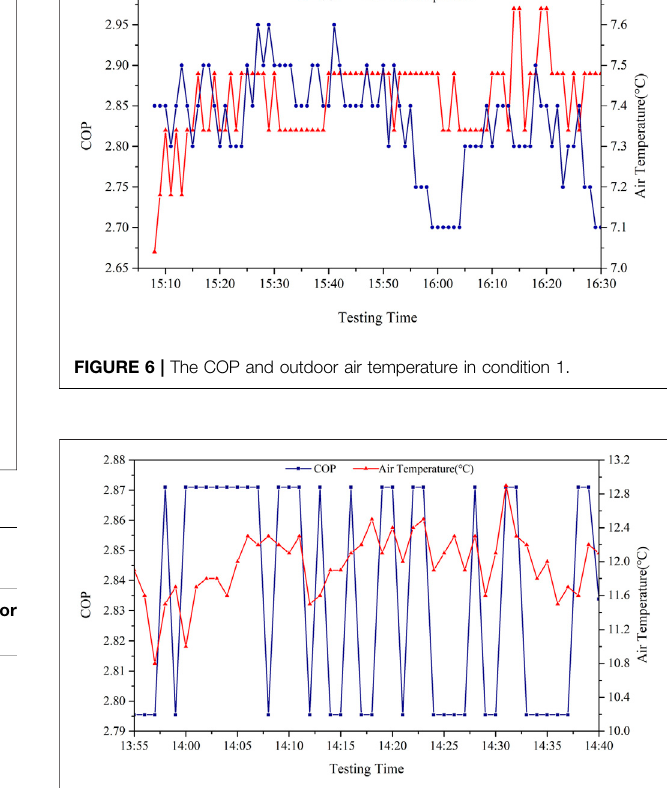
FIGURE 7 | The COP and outdoor air temperature in condition